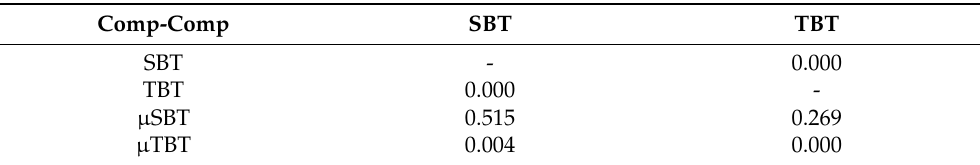
Table 4. Significant differences of bond strength values of resin composite to resin composite on the test method. For group descriptions see Figure 1.